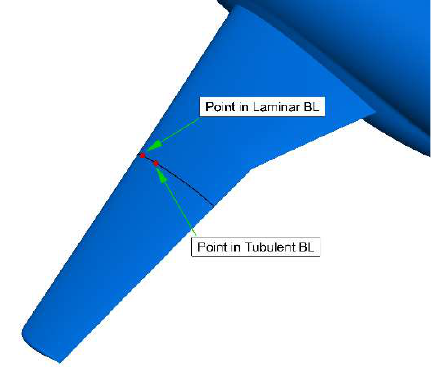
Figure 15. Point locations on the wing.